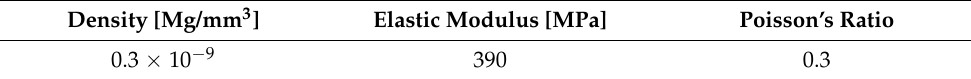
Table 1. Core elastic properties.